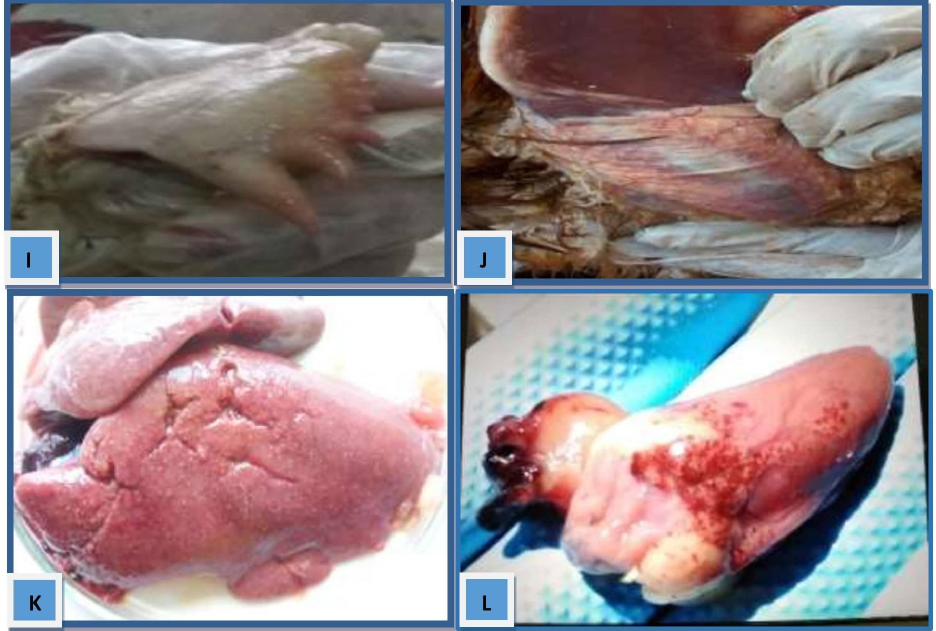
Fig 6. Gross lesions found in chickens in case of fowl cholera. I: Swollen and hardening of comb J: General congestion of skin K: Multiple pin point pale color necrotic lesion on overall liver L: Pin point hemorrhage on fat muscle of